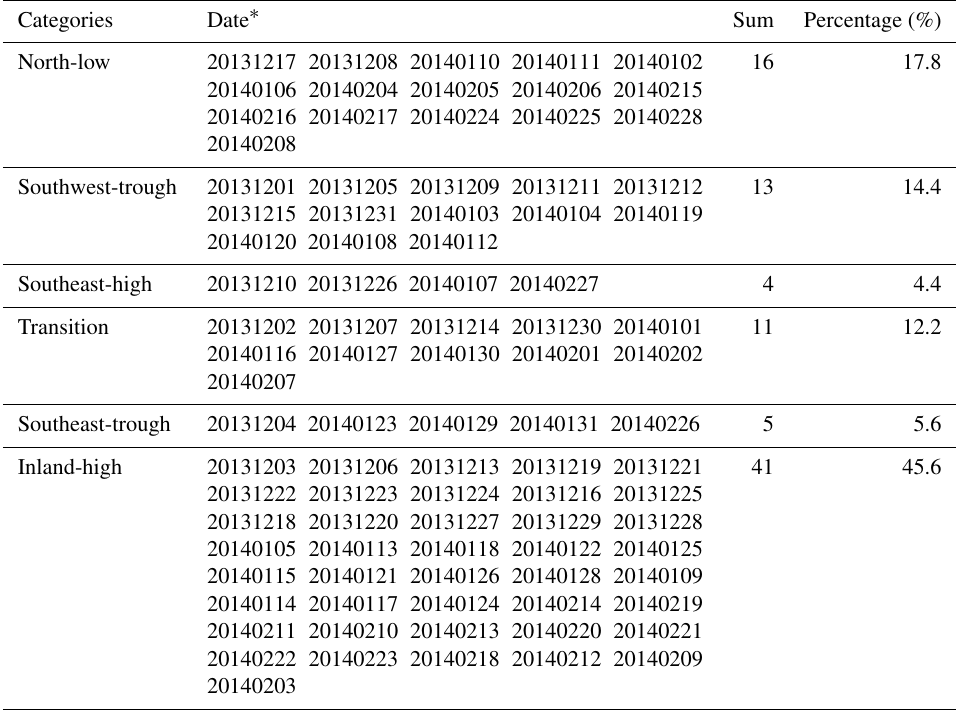
Table 1. Synoptic categories influencing the Guanzhong basin during the wintertime of 2013.